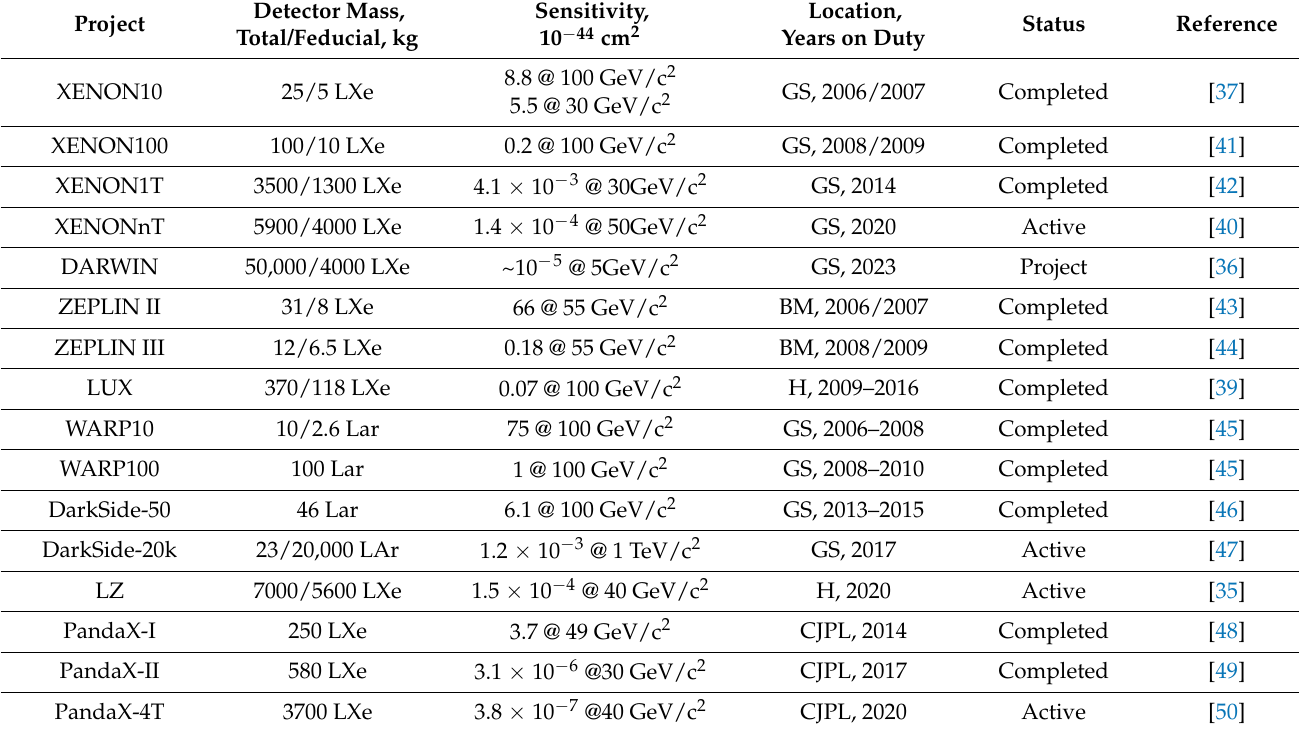
Table 1. Experiments to search for cold dark matter with TPED